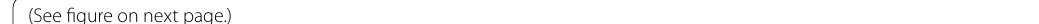
figure on next Fig. 4 Biological effects of circROBO2 in hypoxic cardiomyocytes in vitro. a , c Cell viability analysis of mouse cardiomyocytes. Cardiomyocytes were exposed to normoxic or hypoxia combined with transfecting with si‑NC, si‑circROBO2 miR‑1184 mimics, si‑circROBO2 miR‑1184 or + + si‑circROBO2 si‑TRADD. b , d Cell dysfunction of mouse cardiomyocytes exposed to normoxic or hypoxia combined with transfecting with si‑NC, + si‑circROBO2 miR‑1184 mimics, si‑circROBO2 miR‑1184 or si‑circROBO2 si‑TRADD. All above the experiments were repeated three times. * vs + + + normoxia control group, # vs si‑NC group, & vs si‑circROBO2 group. *** P < 0.001, ## P < 0.01 and & P <